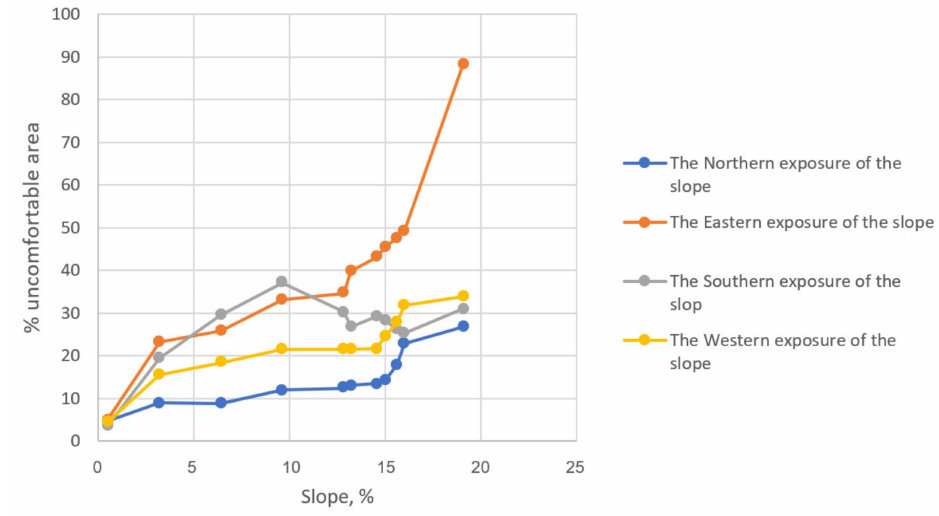
Figure 6. Relationship between gradient, exposure, and percentage of uncomfortable